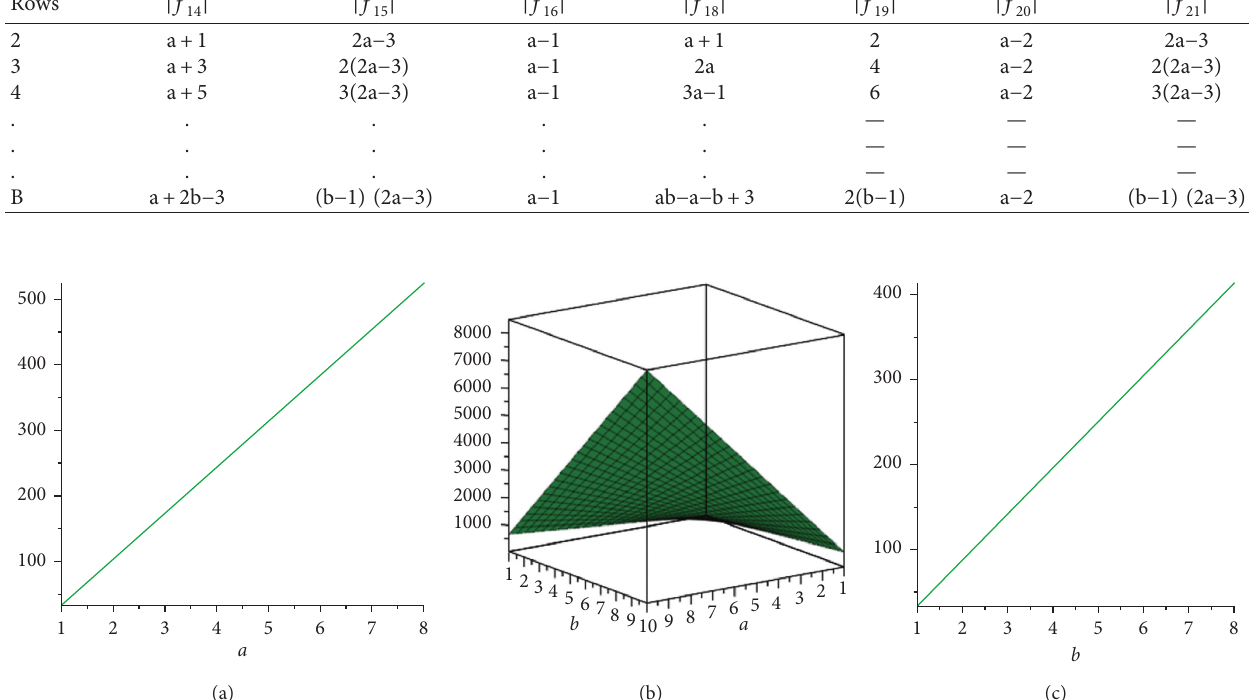
C − I [ a,b ]) , and FI ( Si 2 3